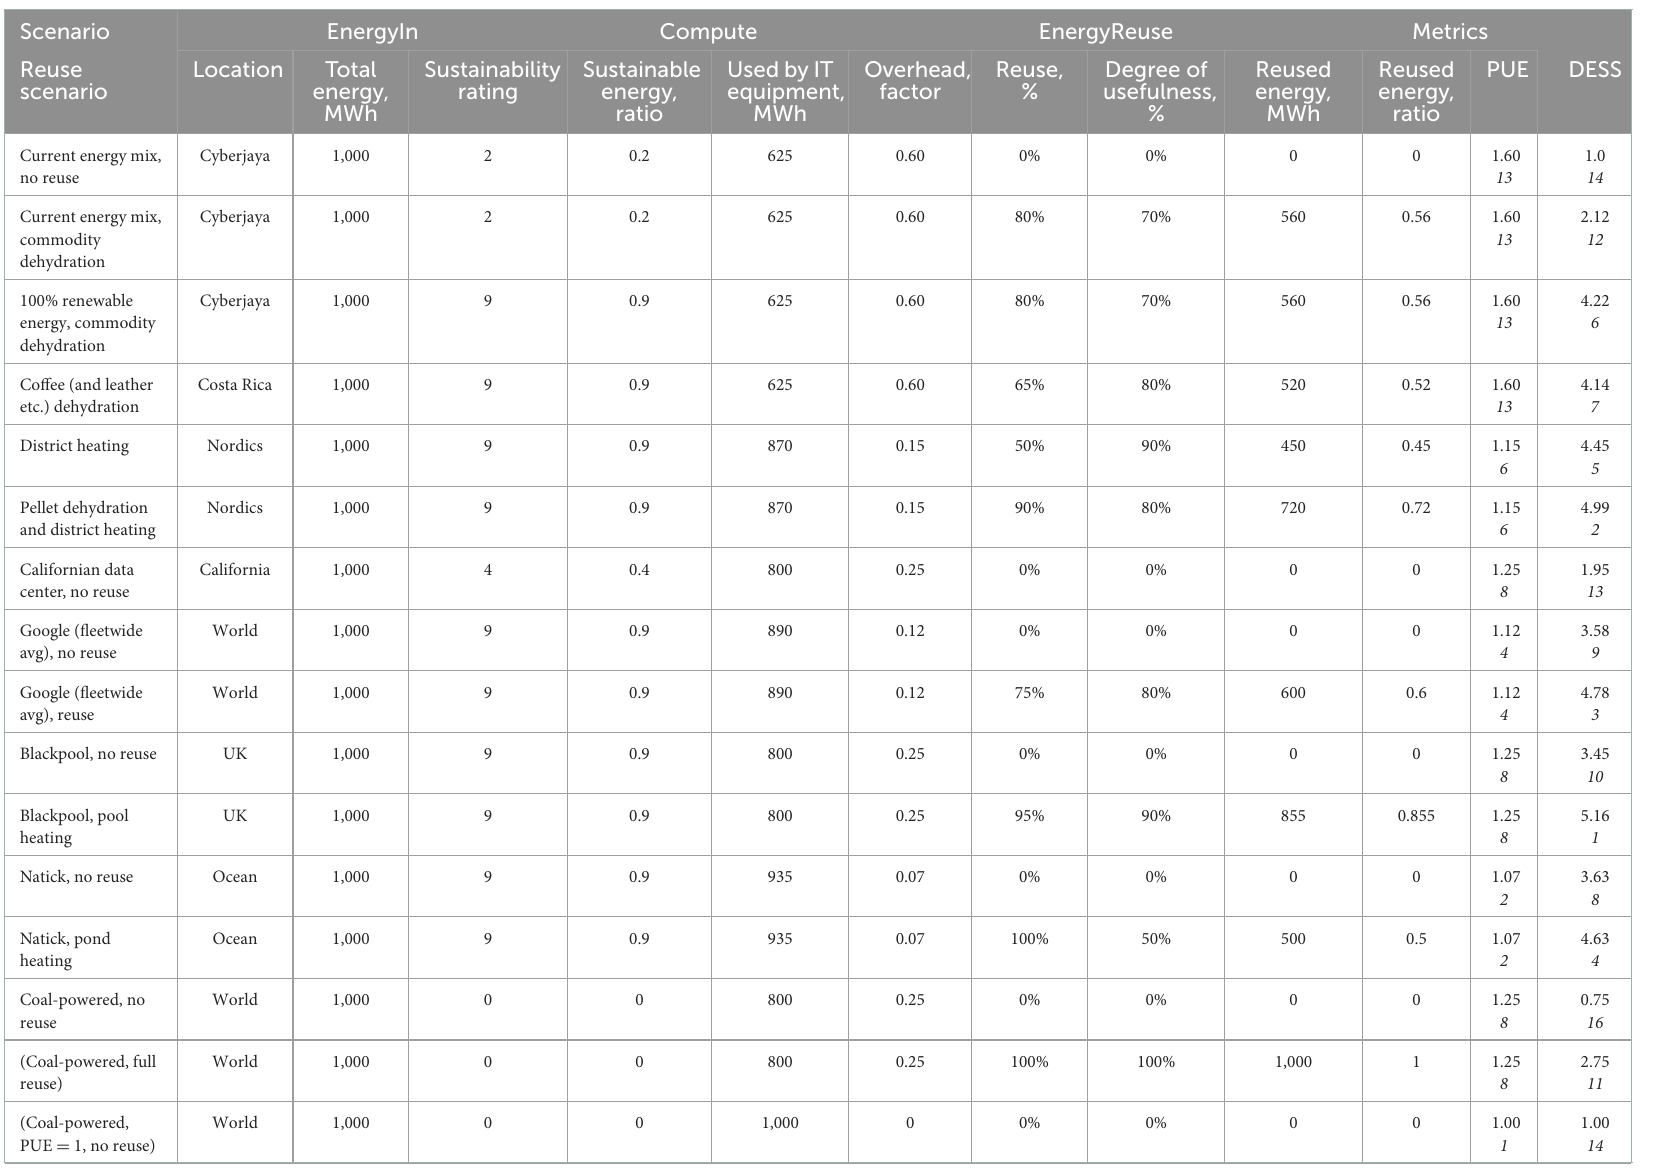
TABLE 3 The annual PUE and DESS of use cases from the paper and a few comparison cases.